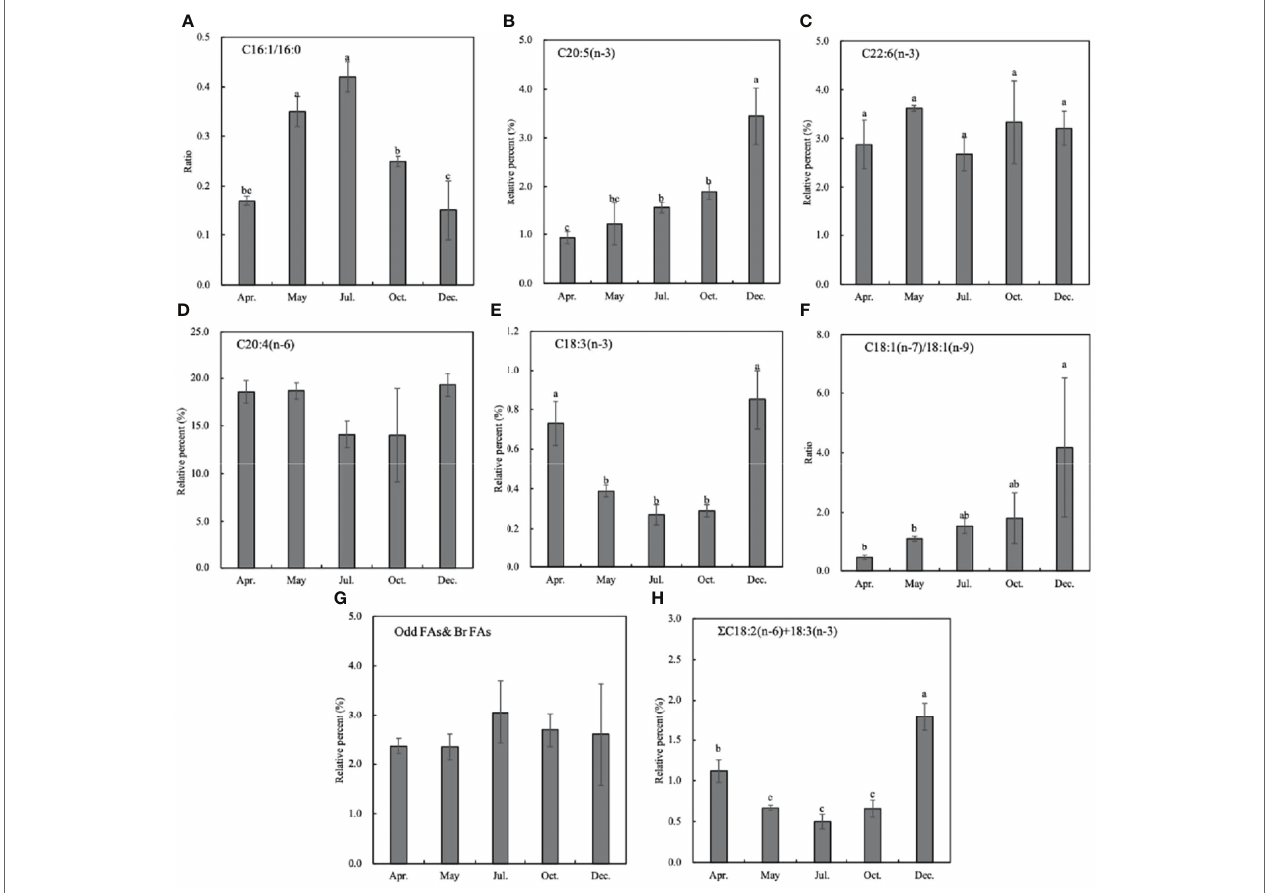
FIGURE 5 | Fatty acid biomarkers of Stichopus monotuberculatus at different months. Food sources are indicated by different fatty acid markers: (A, B) diatoms; (C) flagellate algae or protozoan; (D) brown algae; (E, F) green algae; (G) heterotrophic bacteria; (H) terrestrial organic matter. No letters indicate that there is no significant difference between different